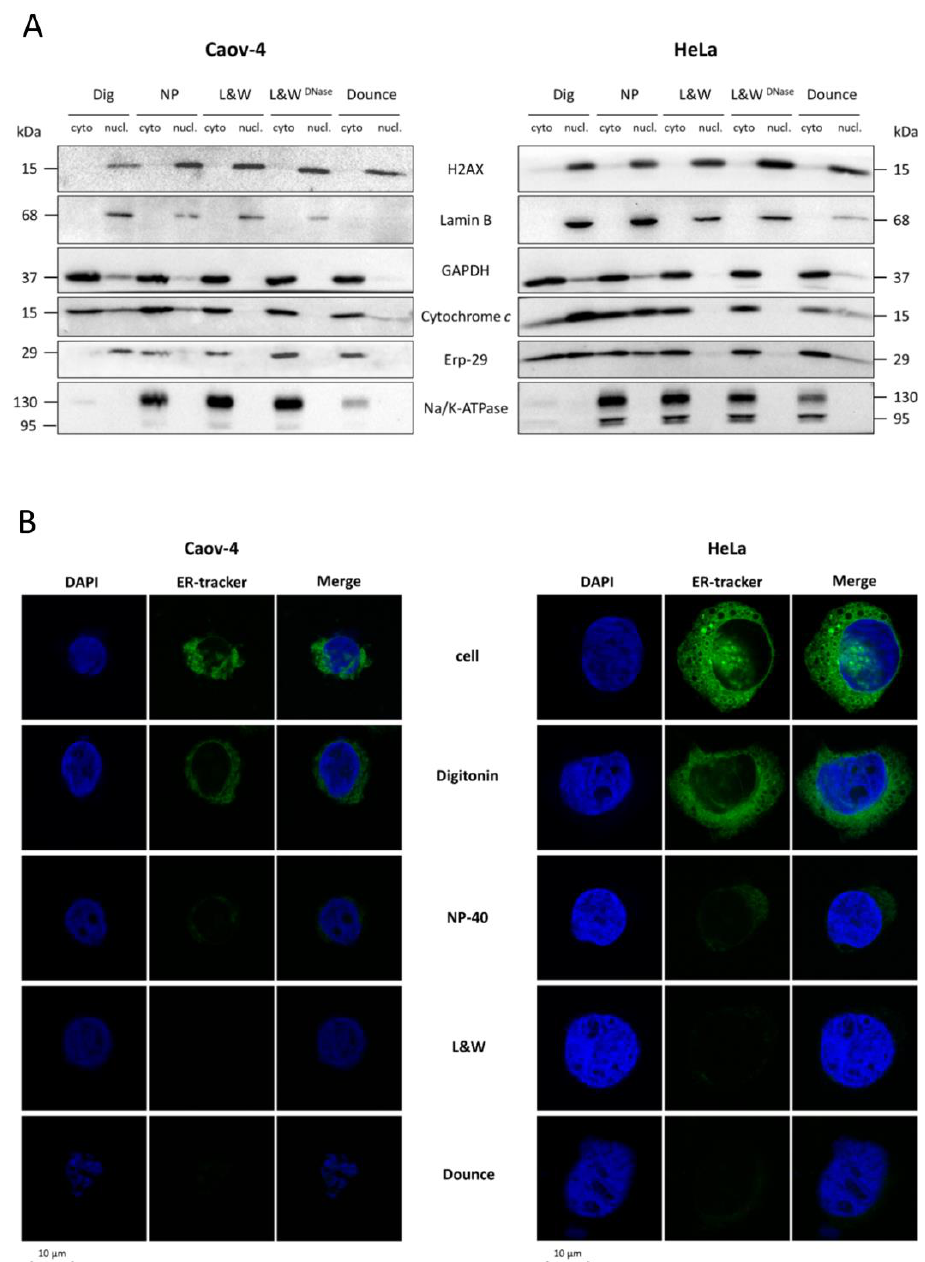
Figure 1. Optimization of the Lyse-and-Wash (L&W) nucleus/cytoplasm fractionation protocol. ( A ) Western Blot analysis of cytoplasmic and nuclear fractions from Caov-4 and HeLa cells obtained by the L&W approach with (hypo) or without (iso) pre-incubation of cells in a hypotonic buffer before lysis. Markers of the cell membrane (Na/K ATPase), ER (ERp-29), mitochondria (cyTable 2. AX) were used to control fractionation quality; ( B ) confocal microscopy of nuclei from Caov-4 and HeLa cells isolated by the L&W approach and its modifications, without pre-incubation of cells in hypotonic buffer or with shortened steps. The samples were stained with DAPI and ER-tracker; ( С ) confocal microscopy of nuclei from HeLa cells isolated using the L&W method with various concentrations of non-ionic detergent (NP-40, concentrations are indicated) in the washing solution. The samples were stained with DAPI and ER-tracker. High light exposure was used for this experiment. L&W, Lyse-and-Wash method.